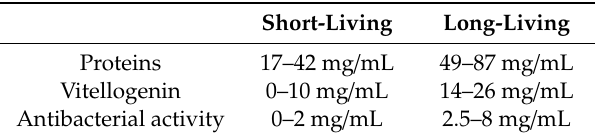
Figure 5. Graphical depiction of proposed physiological ranges in protein, vitellogenin, and antimicrobial level for each season. Red, blue, and grey areas represent short-living, long-living, and mixed populations, respectively. Table 2. Summarization of proposed physiological range for each selected longevity markers based on PCA analysis.